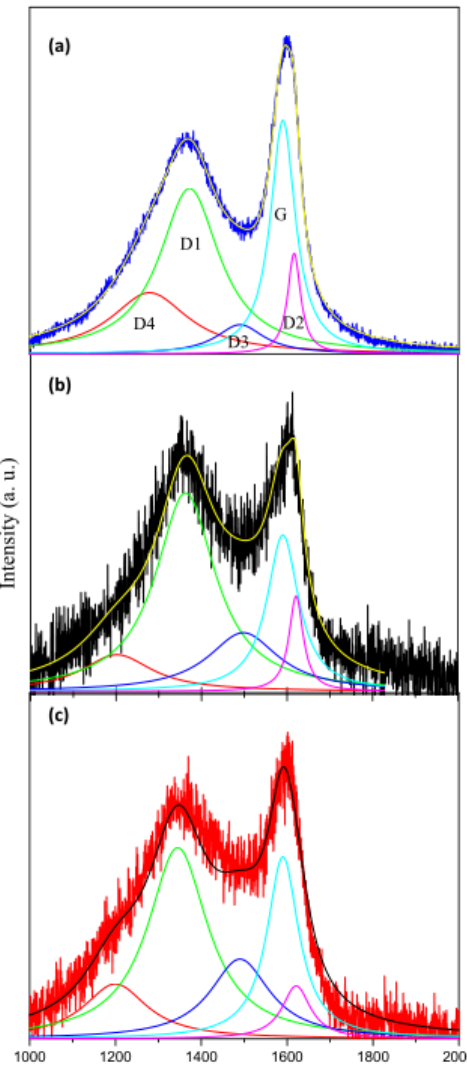
Figure 3. Laser Raman spectra of soot samples: ( a ) LabSoot [30], ( b ) BenchSoot, and ( c ) Printex U. Bands: G (cyan), D1 (green), D2 (pink), D3 (blue) and D4 (red). Table 1. Raman signal contributions for the different samples of soot.